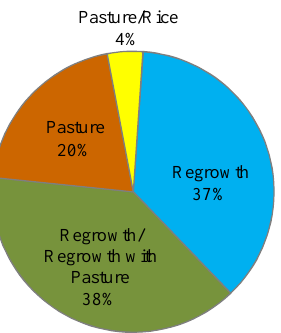
Figure 3. Distribution of the LUC classes in 2011 in deforested polygons without